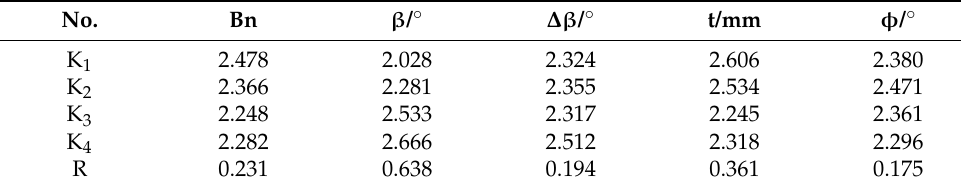
Table 8. Range analysis of the MIX-130 fan